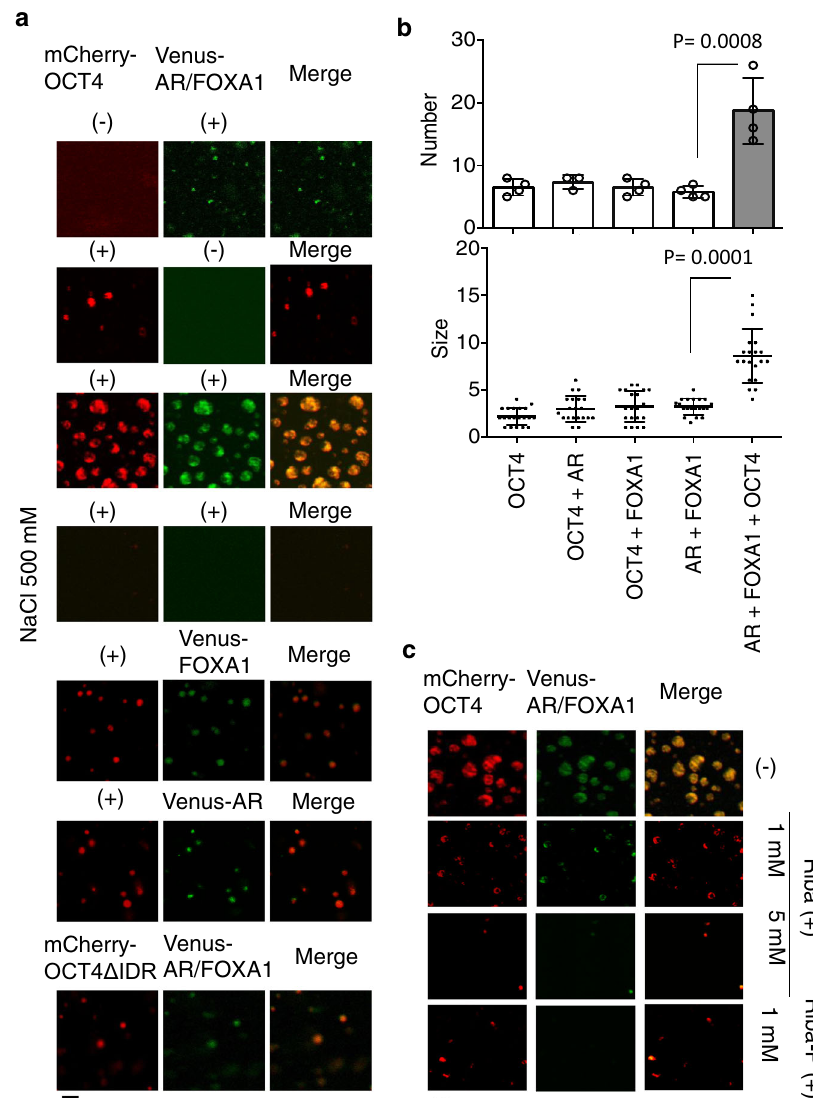
Fig. 7 Enhanced liquid droplet formation by collaborating TF complexes in vitro. a Representative images of droplet formation of mCherry, Venus, mCherry-OCT4, Venus-FOXA1, and Venus-AR (total 10 μ M) as indicated in droplet formation buffer with 125/500 mM NaCl and 10% PEG-8000. Bar = 10 μ m. b Quanti fi cation of droplet formations of mCherry-OCT4, Venus-FOXA1, and Venus-AR in the presence of DHT. Average numbers (AR, AR + FOXA1 + OCT4: N = 4, others: N = 5) or sizes ( N = 20) of droplets. One-way ANOVA and post-doc Dunnett ’ s test were performed. Data are presented as average ± S.D. c Effects of ribavirin and ribavirin-phosphate (P) on the droplet formation. Representative images of droplet formation of mCherry-OCT4, Venus-FOXA1, and Venus-AR (total 10 μ M), as indicated in droplet formation buffer with 125 mM NaCl and 10% PEG-8000. Bar = 10 μ m. Source data are provided as a Source Data fi results indicate that collaborating TF complex of OCT4 is asso- ciated with disease progression to the lethal PC.